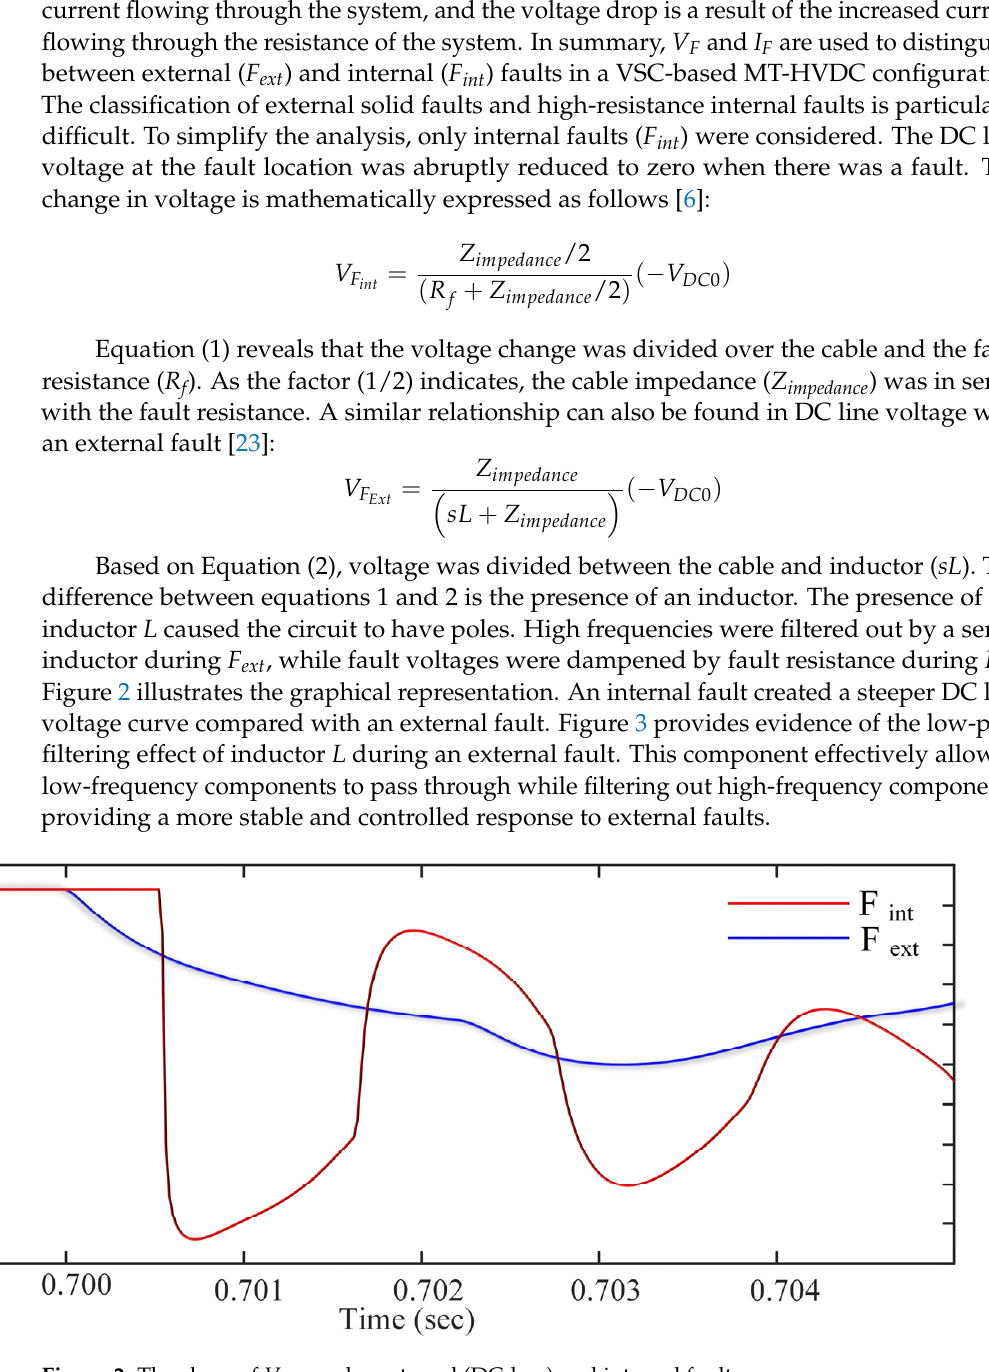
Figure 2. The slope of V DC under external (DC-bus) and internal fault.